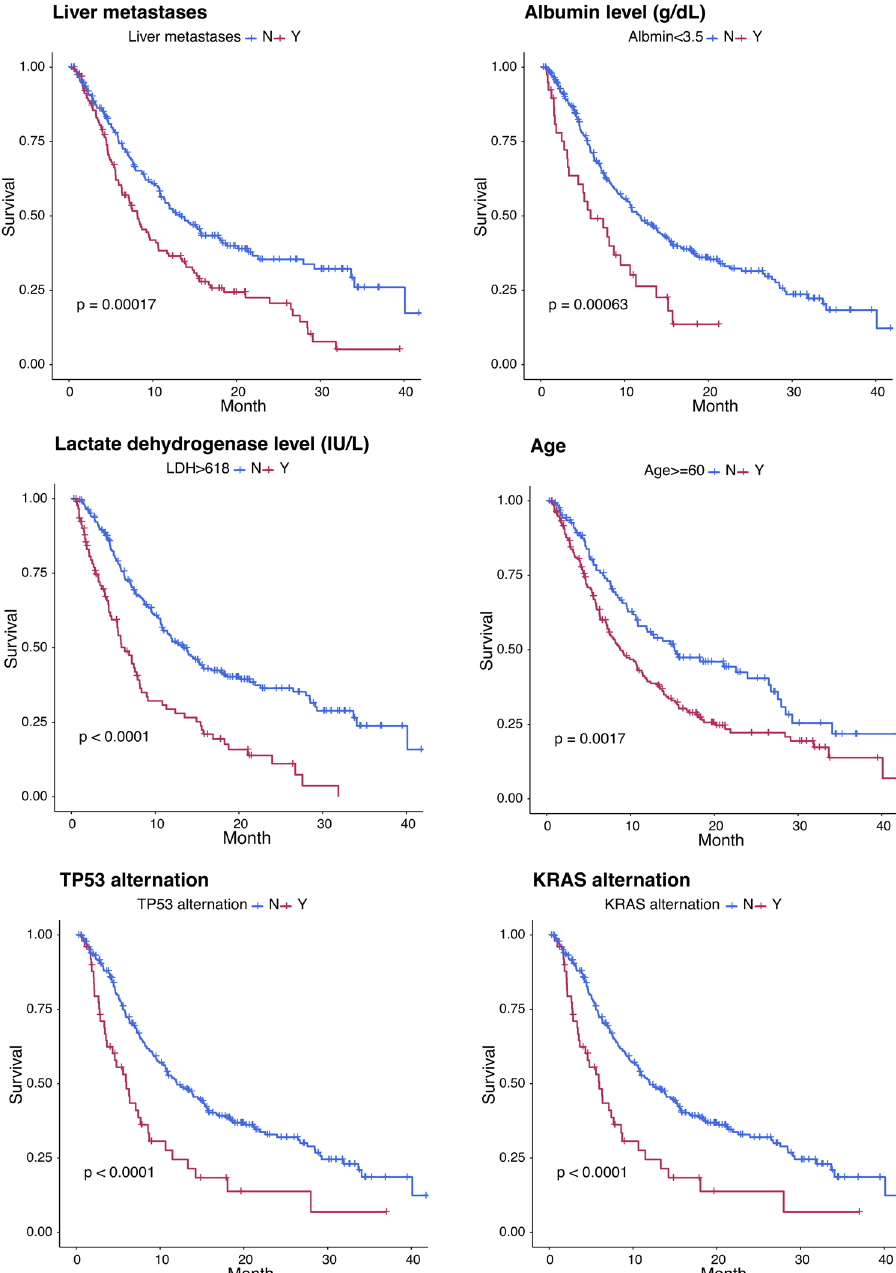
Fig. 4 Independent risk factors predicting overall survival (multivariate were limited at the time of initiation of IMPACT2, and therefore, very few patients received immunotherapy. Whereas we used the top and bottom 20% of TMB values to de fi ne high and low TMB, respectively, other investigators have used different cut-off values 6 – 11 . High TMB has been de fi ned as >23.1 mutations/Mb in patients with melanoma 9 ; >100 mutations per tumor in patients with melanoma treated with antibodies against cytotoxic T-lymphocyte antigen 4 (CTLA-4) 11 ; >10 muta- tions/Mb in patients with non-small cell lung cancer 7 ; and ≥ 20 mutations/Mb in patients with various tumor types treated with immuno-oncology therapy 10 . In the latter study, high TMB was associated with better clinical outcomes compared to patients with lower TMB. High TMB has been associated with response to